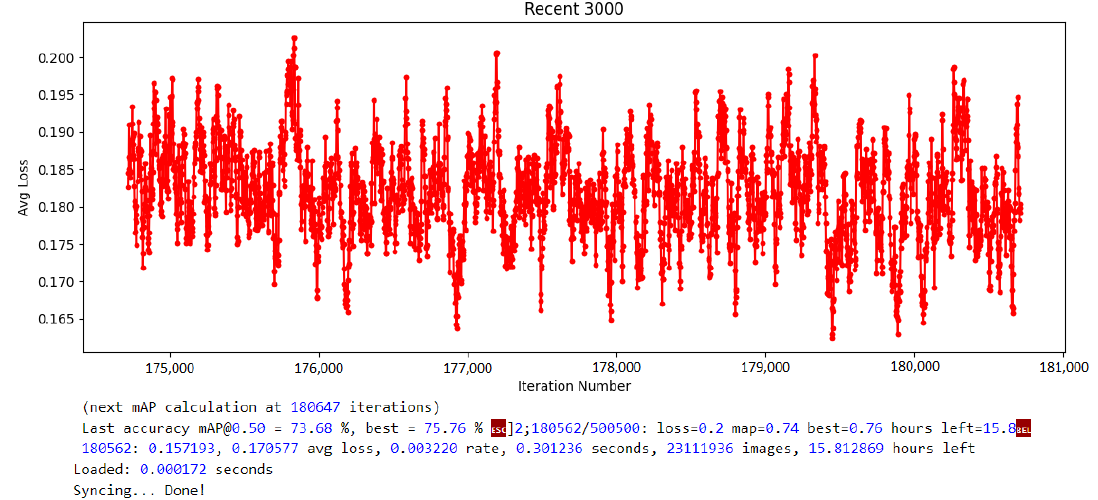
Figure 14. Loss average result over 3,000 units.